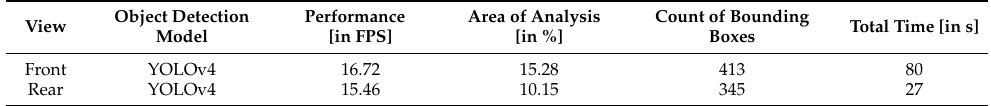
Table 3. General information of Sample scenario #1.